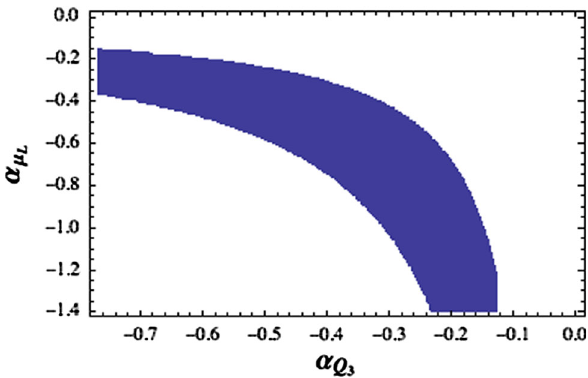
Fig. 6 Couplingoftheheavy Z (cid:7) bosonstotheheavyquarksandleptons